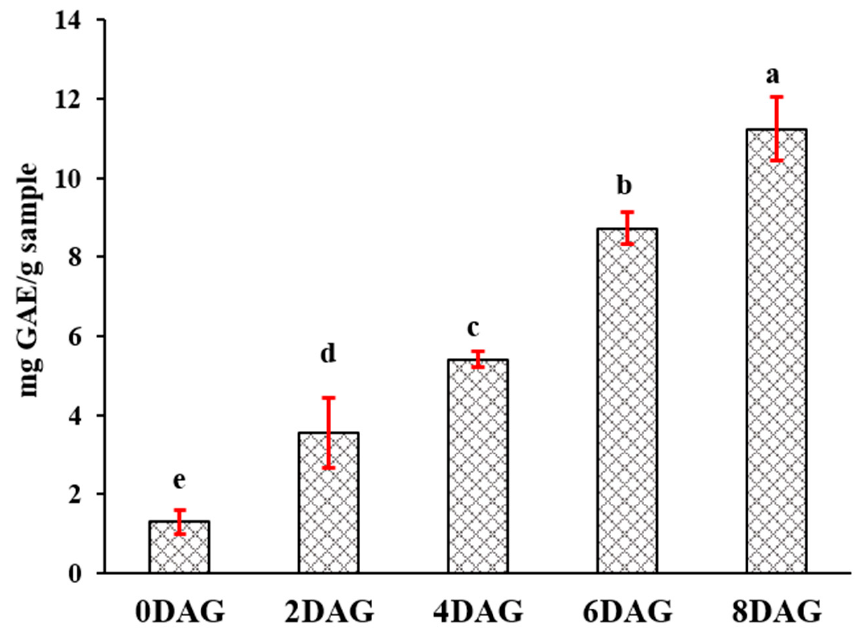
Figure 6. Total phenolic compounds (TPCs) of sacha inchi seeds at different germination times ( p ≤ 0.05). DAG, days after germination. Means followed by different letters are significantly different ( p ≤ 0.05) according to the Duncan’s new Multiple Range Test.